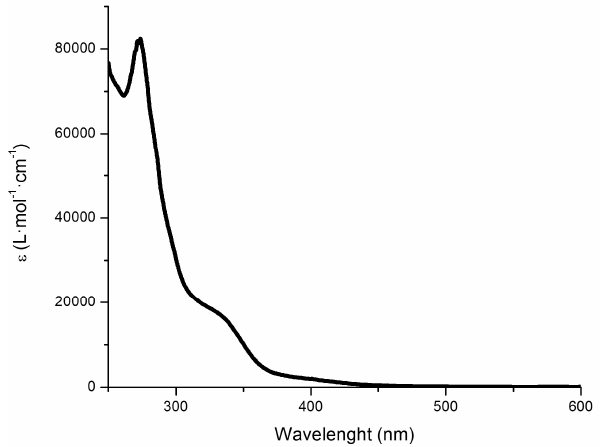
Figure 2. 1 H-NMR spectrum for [CoCl(dpgH) 2 (pytpy)] recorded in DMSO-d6. The insertion of this